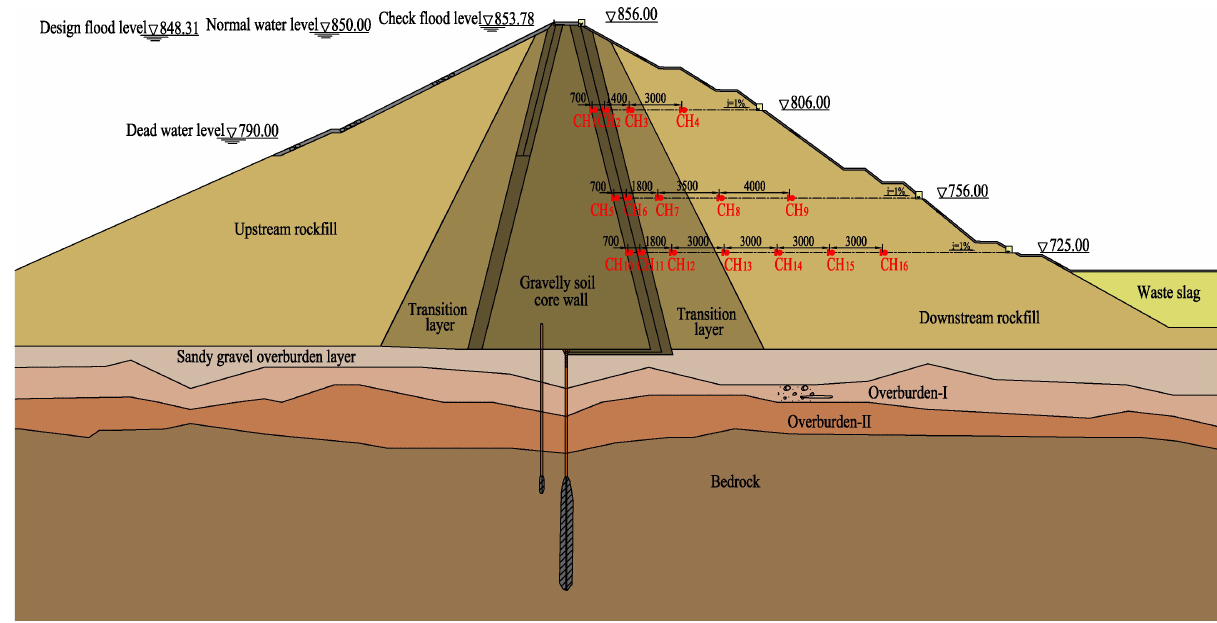
Figure 11. Layout of the hydraulic overflow settlement gauge at profile 0+240 m.